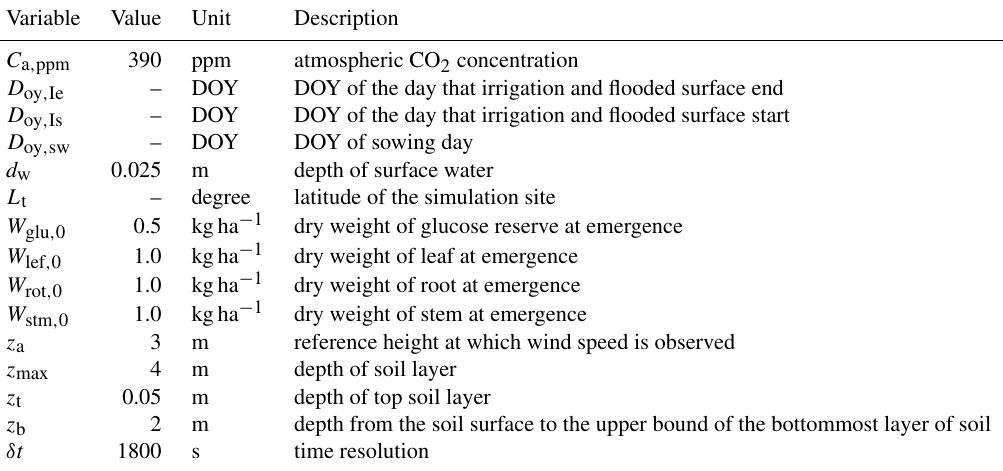
Table 1. Simulation setting